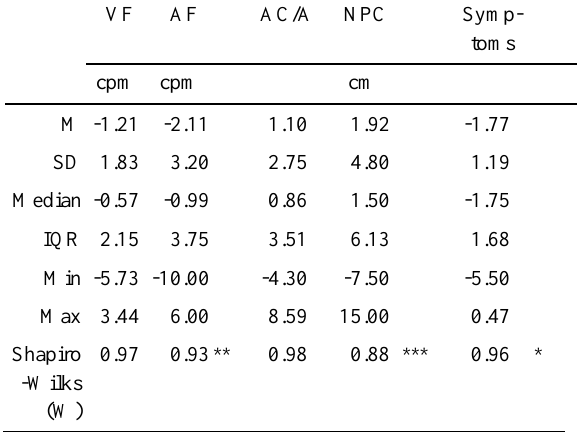
Table 2. Overview of independent optometric variables used for the first set of linear regression models: vergence facility (VF; 12 BO and 3 BI during 60 s at 40 cm), binocular accommodative facility (AF; ±2.00 dpt flipper during 60 s at 40 cm), AC/A-ratio (with ±1.50 dpt at 30 cm), near point of convergence (NPC) and asthenopic symptoms (CISS questionnaire score). Test-for- normality results are also shown